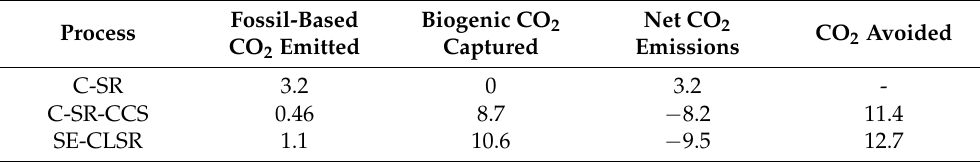
Table 6. Comparison of emissions from processes (kg CO